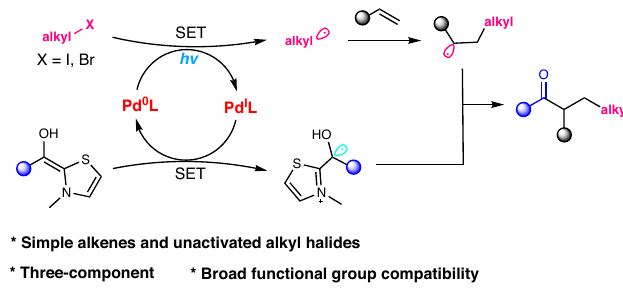
palladium-catalyzed alkylacylation of alkenes. TM transition metal, LG leaving group, X halide, SET single-electron